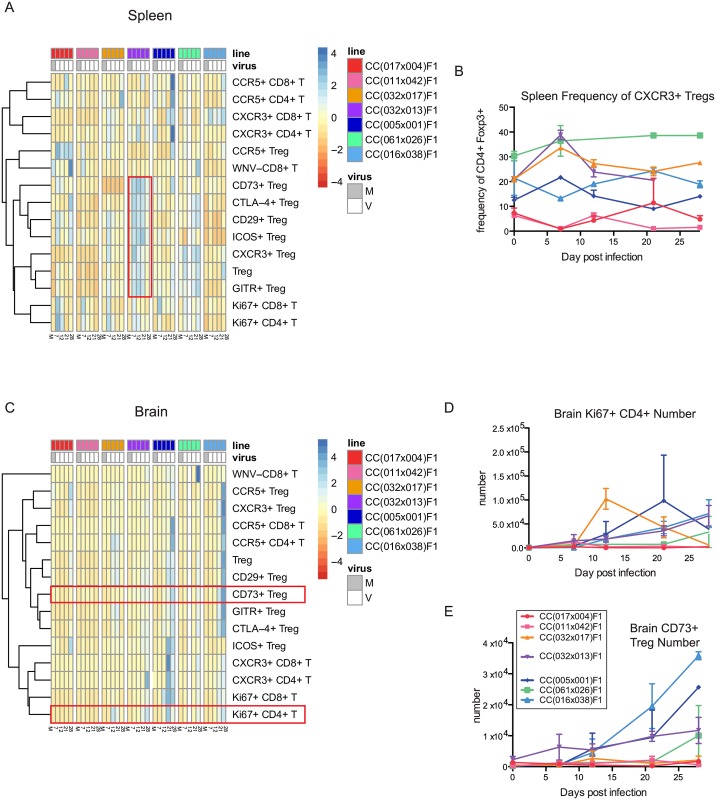
Flow cytometry visualization of the kinetics of the T cell response to WNV infection.(A) T cell subsets and activation markers are shown by heatmap for no disease, chronic, and disease model RIX lines over the time course of infection (spleen), and (B) frequency of CXCR3+ Tregs in the spleen. At baseline, differences in splenic frequency of CXCR3+ Tregs were statistically significant for CC(032x013)F1 compared to CC(017x004)F1 and CC(011x042)F1, (p<0.001). (C) T cell subsets and activation markers shown by heatmap in the brain, and (D) brain Ki67+ CD4 T cell numbers, and (E) brain CD73+ Ki67+ Treg numbers. N = 3 mice per group for all time points shown.